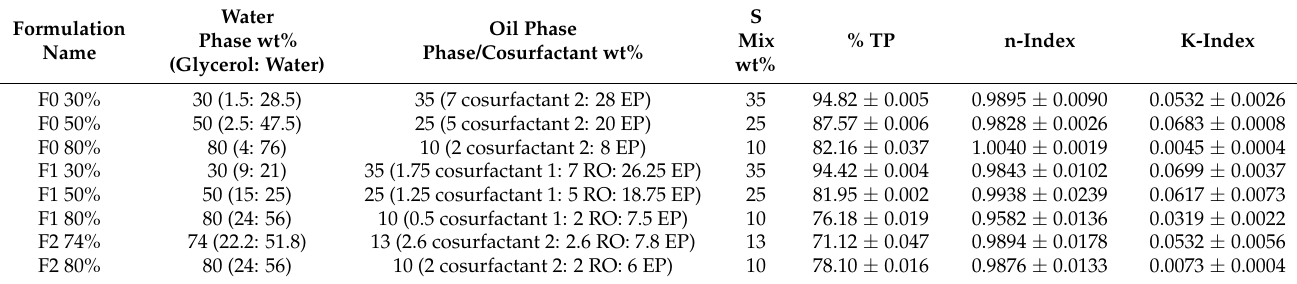
Table 1. Composition of the selected nanoformulations (transient phases and corresponding nanoemulsions), their percent- age of transmittance (%TP) at 600 nm measured 24 h after preparation, and flow rheological parameters (n-flow behavior index, K-consistency index) measured 7 days after